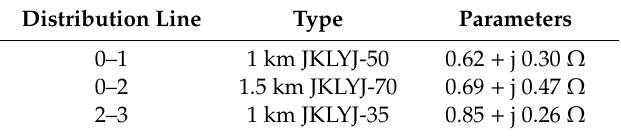
Table 1. Microgrid distribution line